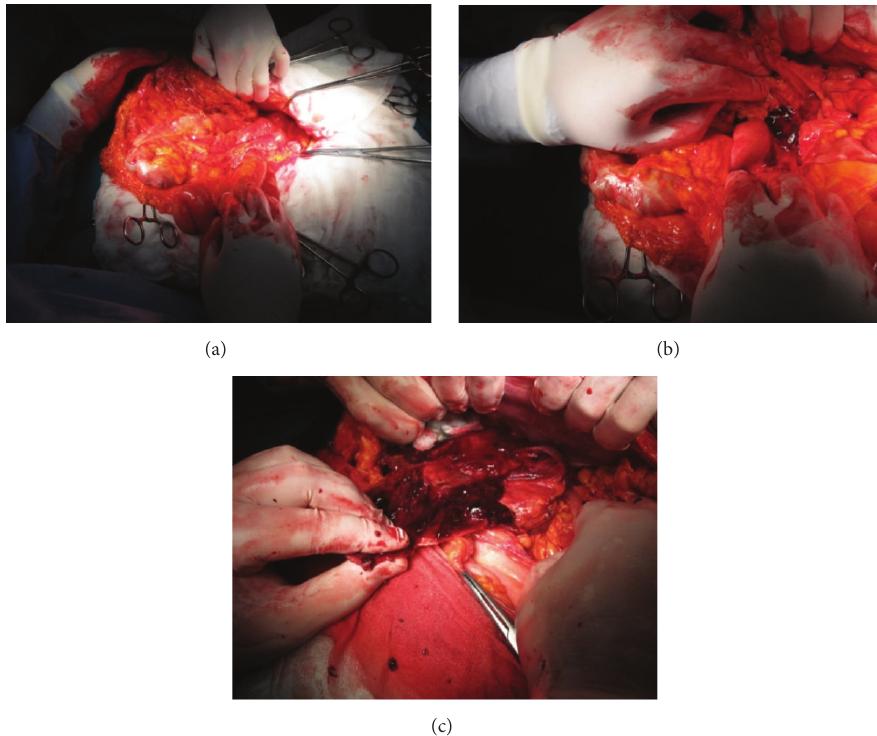
Figure 3: Intraoperative aspects: intraperitoneal blood, retroperitoneal and splenic hematoma.